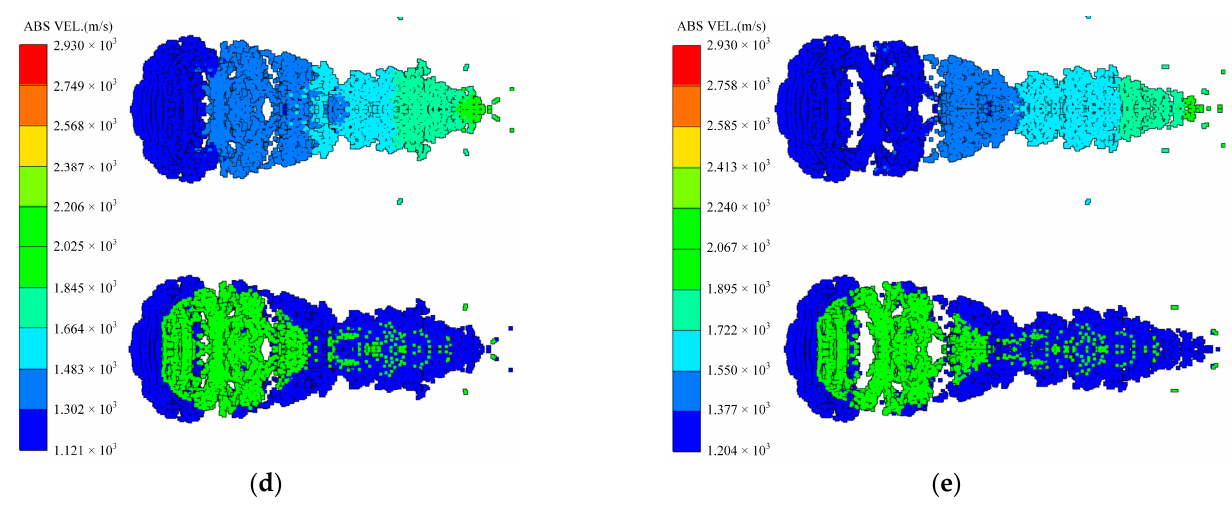
Figure 7. Closing phase: ( a ) t = 30 μ s; ( b ) t = 45 μ s; ( c ) t = 60 μ s; ( d ) t = 75 μ s; ( e ) t = 90 μ s.